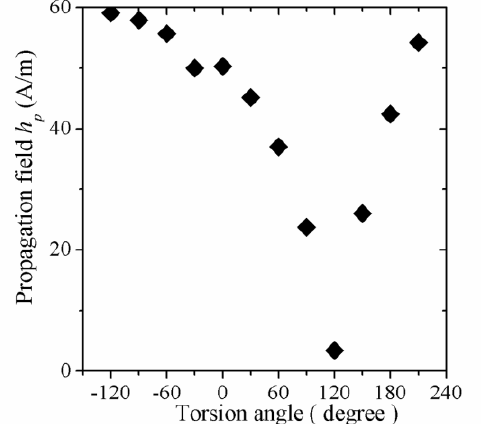
Figure 9. Propagation field h (Co Fe ) B Si 0.94 0.6 72.5 15 12.5